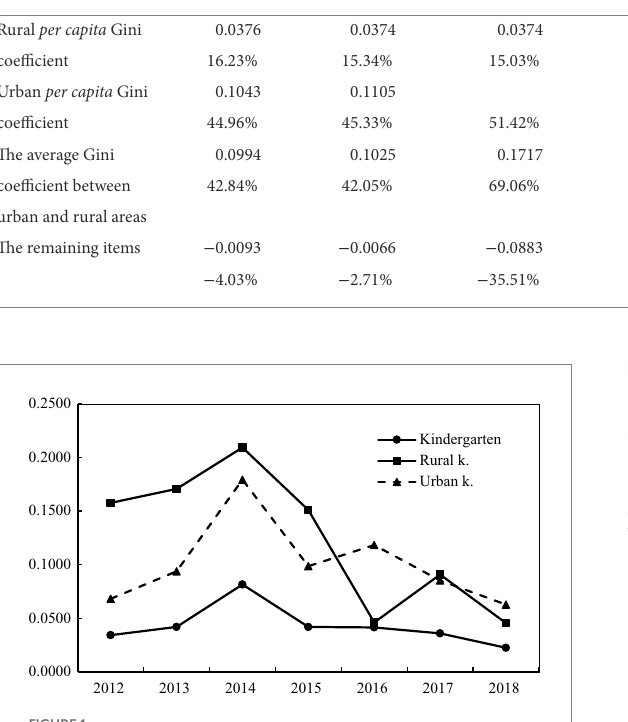
FIGURE 1 Polarization trend of total income for